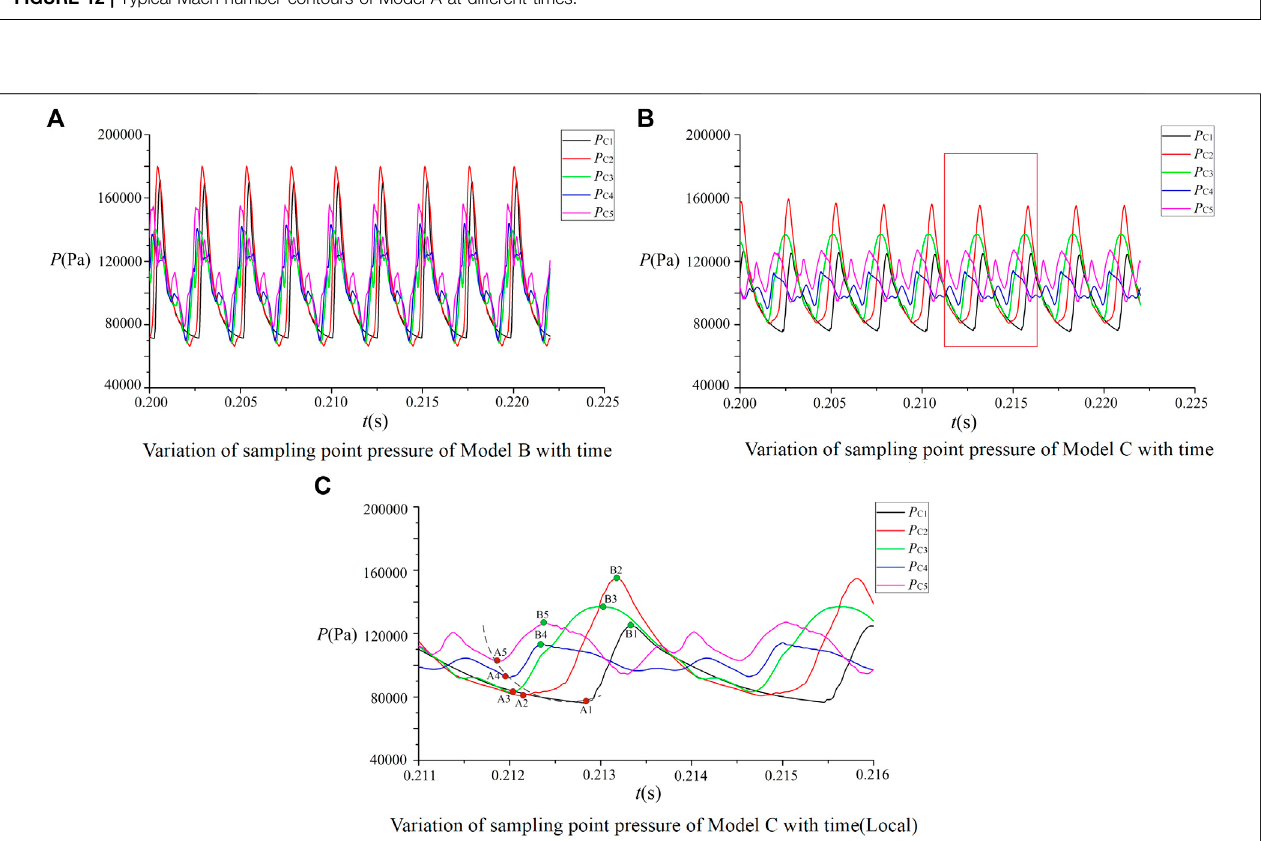
FIGURE 13 | Variation of pressure at cavity sampling